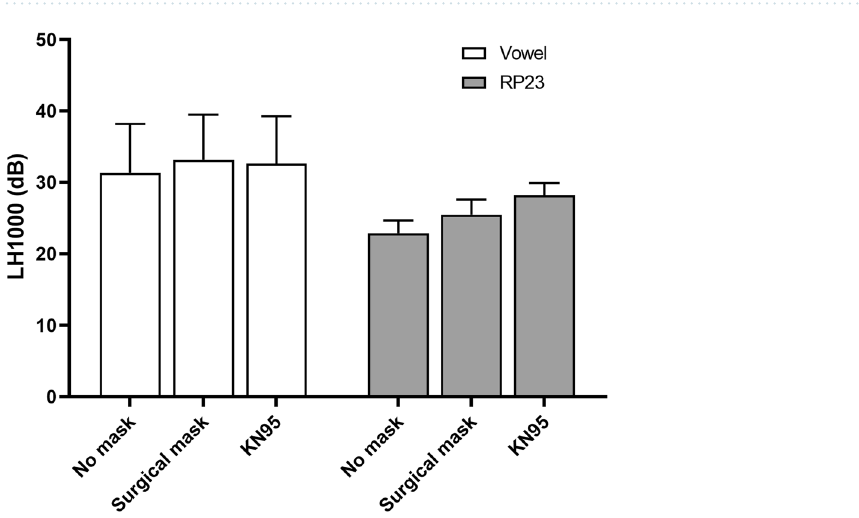
Figure 3. Mean low/high ratio at 1000 Hz for all conditions. Error bars indicate standard deviation. RP23 = The 2nd and 3rd sentences of the Rainbow